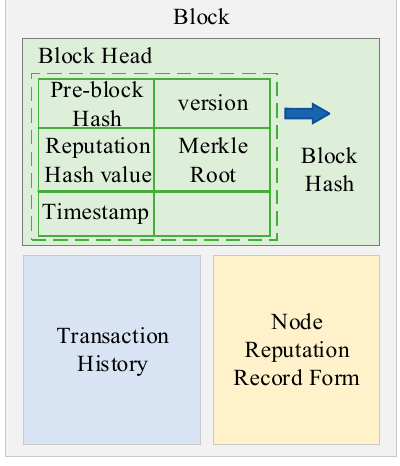
Figure 2. Block structure.